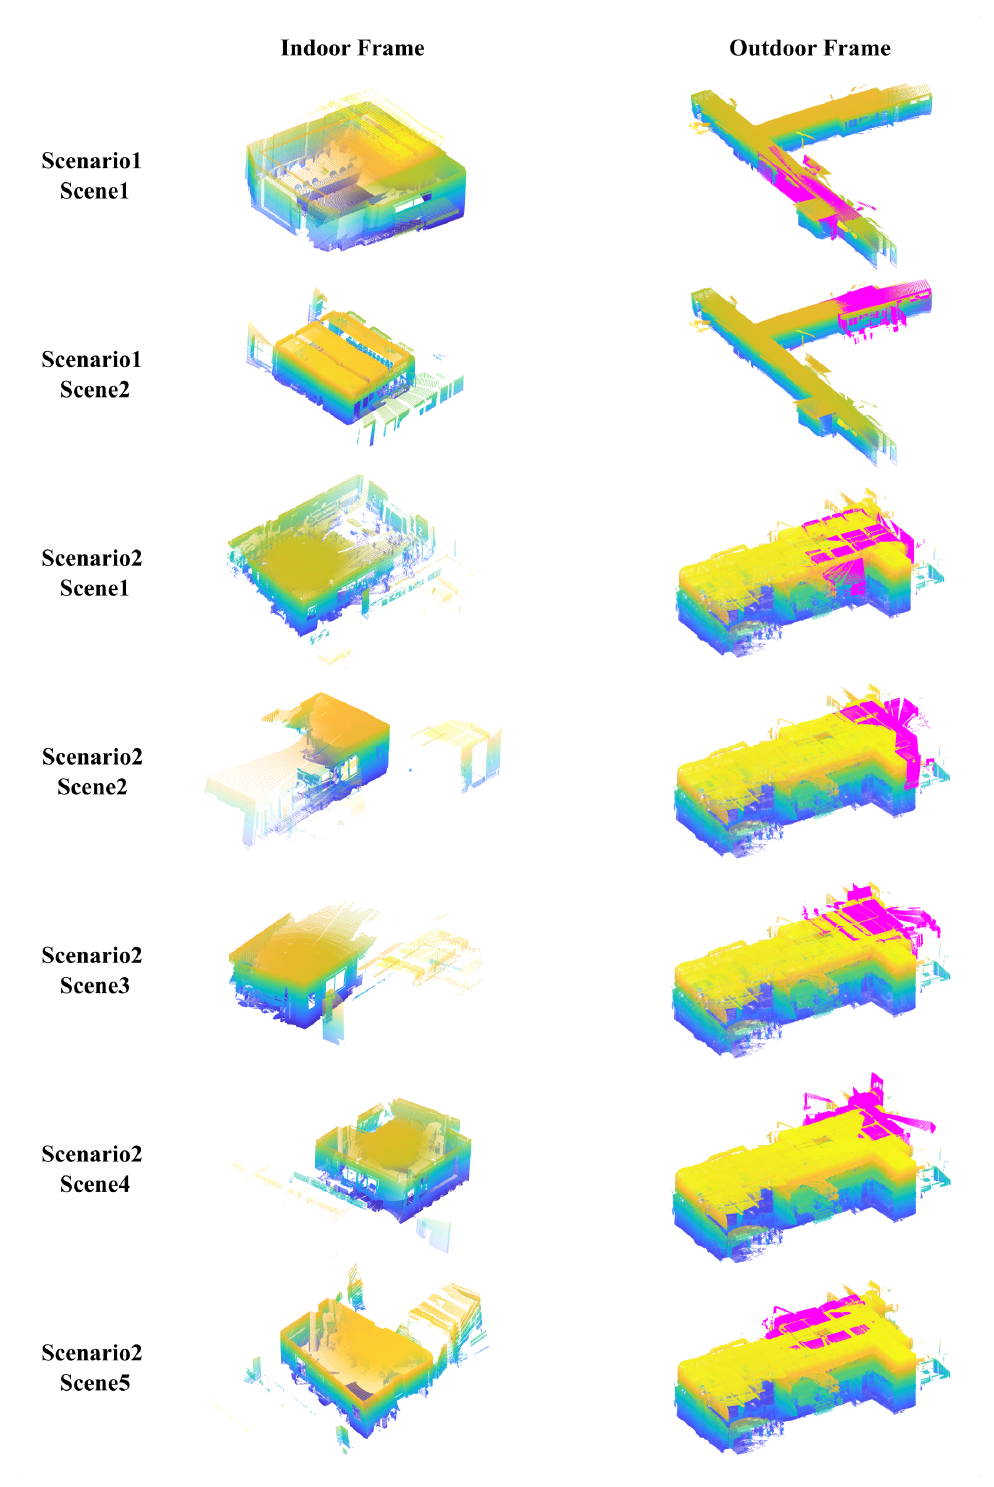
Figure 8. The collected dataset in two different scenarios. The point clouds of the indoor frames are presented in the left column, and the corresponding outdoor frames, colored in magenta, and their locations in the outdoor model are presented in the right